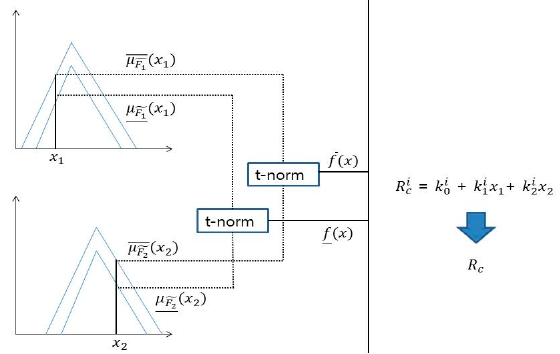
Figure 12. Process of inference computation on the IT2FIS.